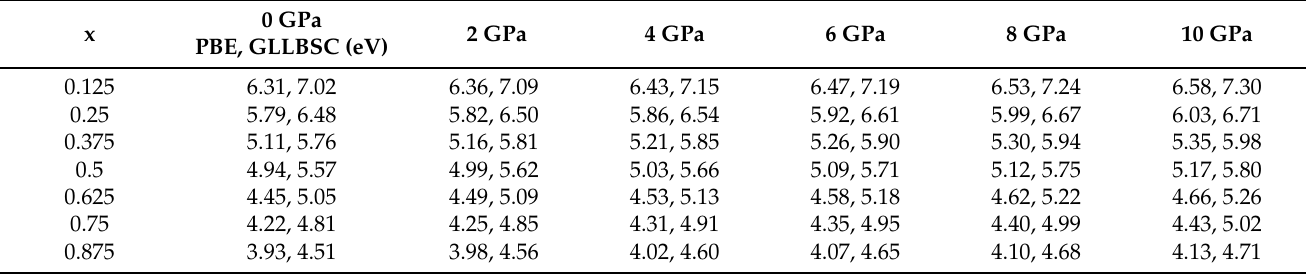
Table A1. Detailed band gap energy ( E g ) of 2 × 1 × 1 rocksalt Mg 1 − x Zn x O for varied concentration with external pressure from 0 to 10 GPa in 2 GPa increments corresponding to Figure